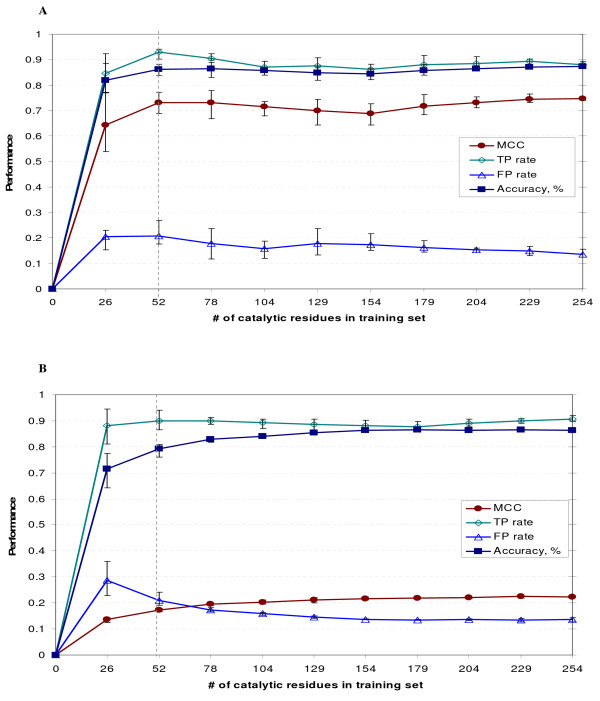
The learning curve of the SMO algorithm with the 7-attribute set in 10-fold cross-validation analysis using (A) a balanced dataset or (B) the whole benchmarking dataset as a test set.